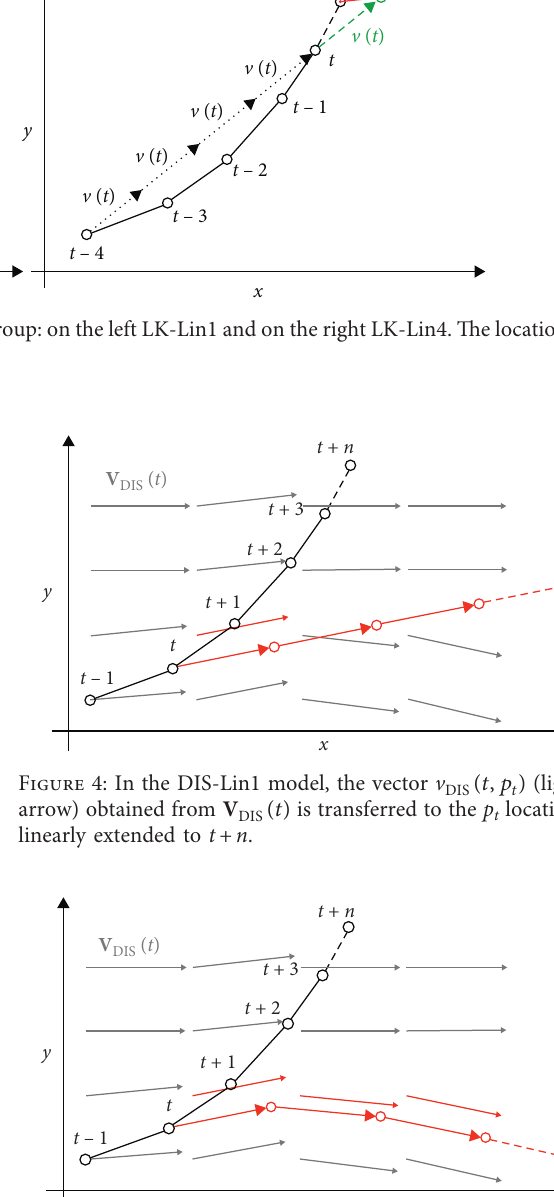
Figure 5: Schematic of the DIS-Rot1 model (orange path), where the velocity is updated every time step by transferring the velocity ( t,p ) (light orange arrow) closest to p vector v DIS (orange circles, for t > 0) in V DIS( t ) , to the P t + Δ t t � 0) or P t + 1 location to